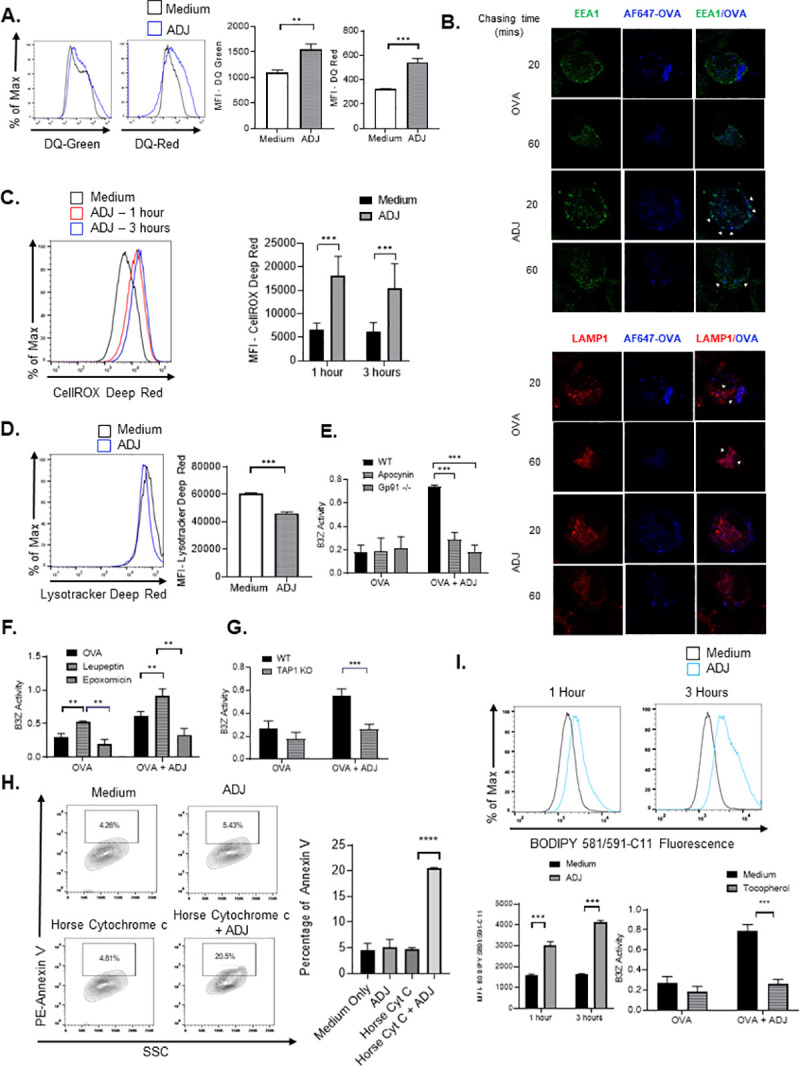
Carbomer-based adjuvant engages the endosome-to-cytosol pathway of cross-presentation.(A) BMDCs (2x105 cells/well) were cultured in media containing DQ-OVA (20ug) ± ADJ (1%) for 6 h and the fluorescence of DQ-green (FITC channel) or DQ-red (PE-Texas Red channel) was quantified using flow cytometry (B) BMDCs were pulsed with Alexa 647-OVA (20ug) ± ADJ (1%), chased at the indicated time-points, and immunostained to assess the degree of OVA co-localization with either EEA1+ve (early endosomes) or LAMP1+ve (lysosomes) organelles. Scale bars, 10 μm. (C-D) BMDCs were cultured in media ± ADJ (1%) for the indicated time (1 or 3 hrs) and stained with CellRox and Lysotracker dyes to measure total cellular ROS and intracellular acidity, respectively. The fluorescence of CellROX and Lysotracker was quantified by flow cytometry. (E) B3Z cross-presentation assay was performed using gp91-deficient (gp91-/-) BMDCs or DCs treated ± the NADPH oxidase inhibitor (apocynin). (F, I) β-galactosidase production by B3Z cells after co-culture with BMDCs pre-treated with OVA ± ADJ in the presence/absence of tocopherol (IμM, 100μM), leupeptin (F; 50μM), or epoxomycin (F; 10μM) for 5 h. (G) β-galactosidase production by B3Z cells after co-culture with ADJ/OVA-treated WT or TAP1-deficient DCs pre-treated with OVA ± ADJ for 5 h. (H) ADJ-treated DCs were cultured with horse cytochrome C (5mg/ml) ± ADJ (1%) for 24 hours to assess endosomal leakage of antigen into cytosol. Cell viability (as a read-out for antigen leakage-induced apoptosis) was measured by Annexin V staining. (I) BMDCs were cultured in media ± ADJ (1%) for 1 and 3 h, stained with BODIPY 581/591-C11, and a blue-shift of BODIPY 581/591-C11 fluorescence was measured using flow cytometry. Data are representative of 3 independent experiments. Error bars are the SEM; **P<0.001; ***P<0.0001 (Student’s t-test- A, C, D, G and I; ANOVA test–B, E, F, G, H).